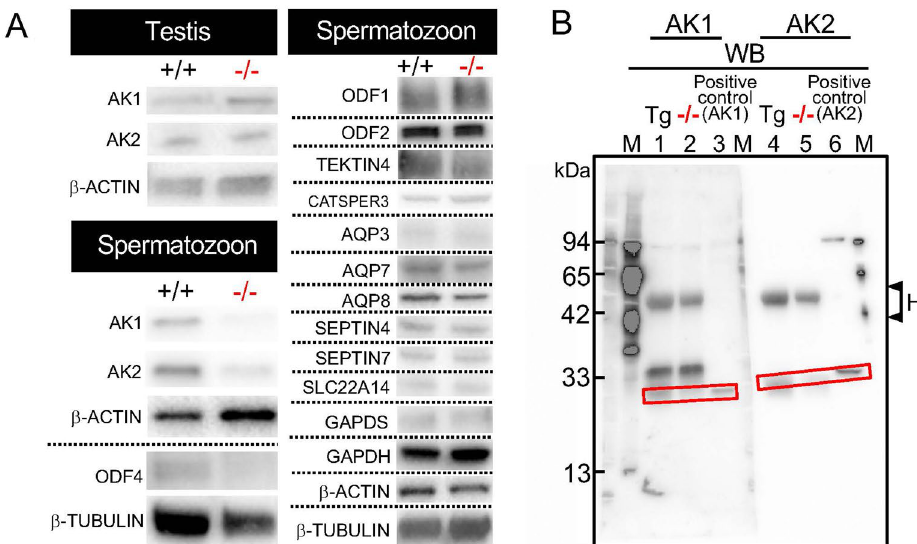
Figure 4. AK1 and AK2 in testis, spermatozoa, flagellar proteins ( A ) and immunoprecipitation (IP) ( B ) . + / + : Odf4 +/+ . −/−: Odf4 −/− . Western blotting. ( A , B ) Cropped images. ( A ) (Left) Testicular and cauda epididymal sperm extracted samples. β-ACTIN and β-TUBULIN: internal controls. AK1 and AK2 are detected in both Odf4 +/+ testes (Top) and cauda spermatozoa (Bottom); however, they are detected in Odf4 +/+ , but reduced or hardly detected in Odf4 −/− cauda spermatozoa (Bottom). Further cropped images are shown in the supplementary Fig S6 for testis (Top) and spermatozoon (Bottom). These original full-length images with different exposure times are shown in the supplementary SD2 for testis (Top) and SD3 spermatozoon (Bottom). (Right) All flagellar proteins extracted from Odf4 +/+ and Odf4 −/− mice examined are immunopositive for each corresponding antibody: ODF1, ODF2, TEKTIN4, CATSPER3, AQP3, AQP7, AQP8, SEPTIN4, SEPTIN7, SLC22A14, GAPDS, GAPDH, β-ACTIN and β-TUBULIN. Further cropped images are shown in the supplementary Fig S7. These original full-length images with different exposure times are shown in each corresponding supplementary SD from SD4 to SD13. ( B ) Cropped images of IP with anti-GFP antibody for the extracts in RIPA buffer from Tg(Odf4-Egfp) and Odf4 −/− (control) spermatozoa and western blotting with anti AK1 (23 kDa) and AK2 (30 kDa) antibodies for the same blotted membrane after SDS-PAGE. Lanes 1 and 4 (Tg): Tg(Odf4-Egfp) sperm extracts. Lanes 2 and 5: Odf4 −/− (−/−) sperm extracts. Lanes 3 and 6: Positive control (IP-untreated Odf4 +/+ samples) to identify AK1 and AK2, respectively. The AK1 and AK2 signals are times are shown in the supplementary SD14. H on the right side indicates the position of the IgG heavy chain (approximately 55 kDa). M, marker proteins (protein molecular marker and/or prestained